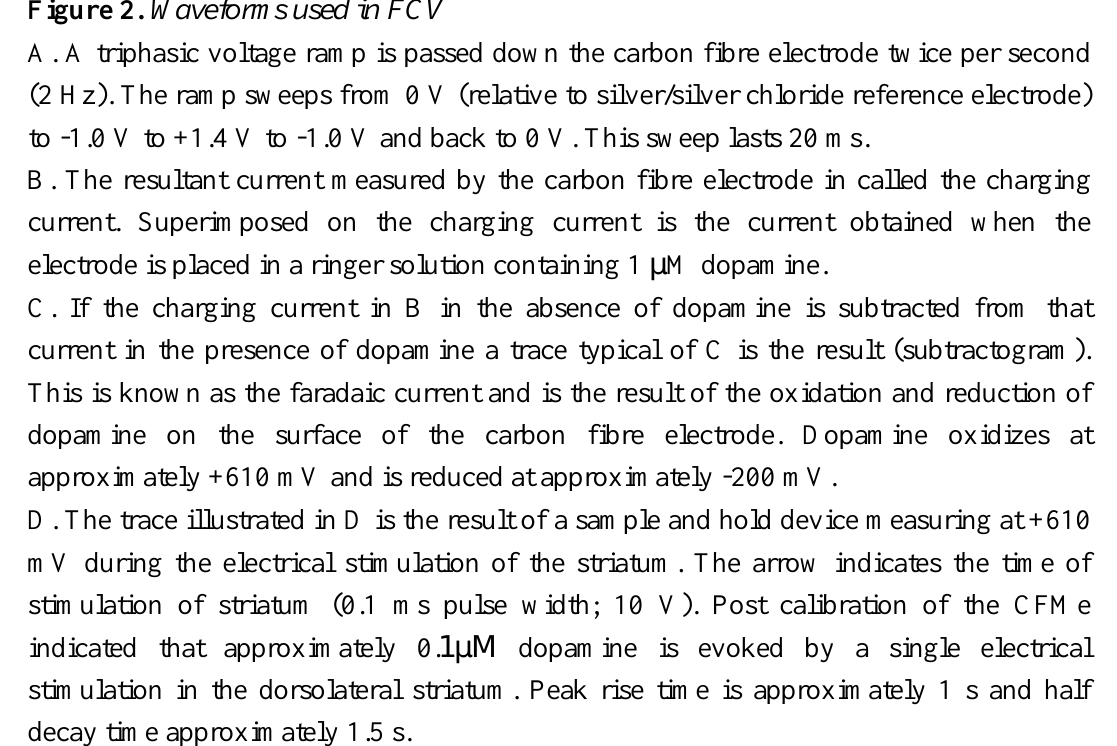
Figure 2. Waveforms used in